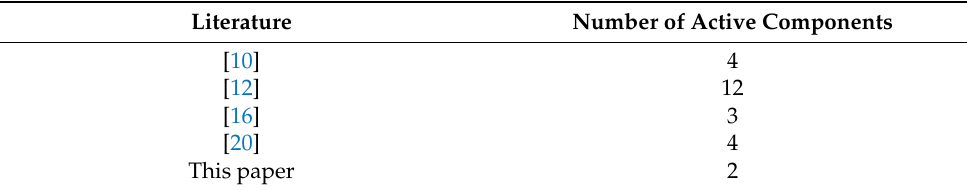
Table 1. The number of APCM active components used in the existing literature.